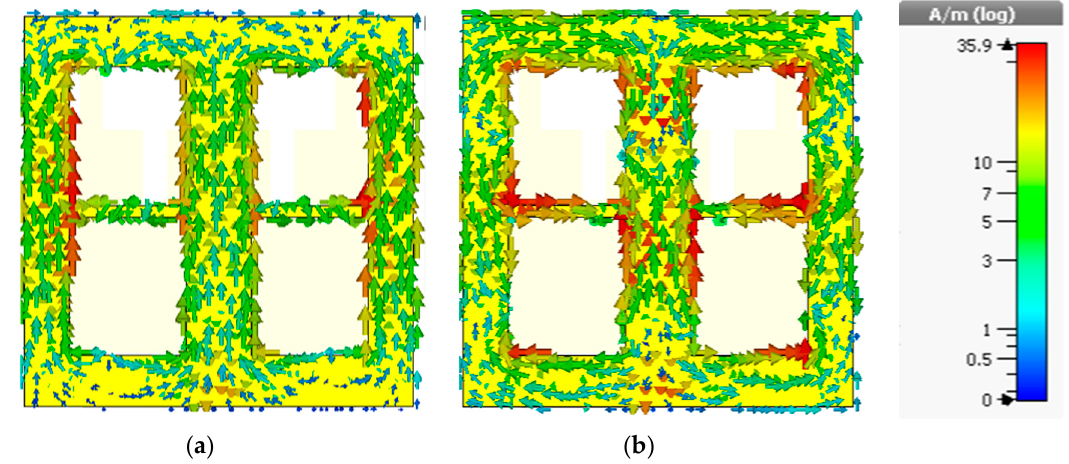
Figure 19. The current distribution of the ground plane of the antenna. ( a ) 3.532 GHz; ( b ) 6.835 GHz. Table 2. The comparison between the results of some previous work with the present one (here represents the wavelength of the corresponding lower resonant frequency).